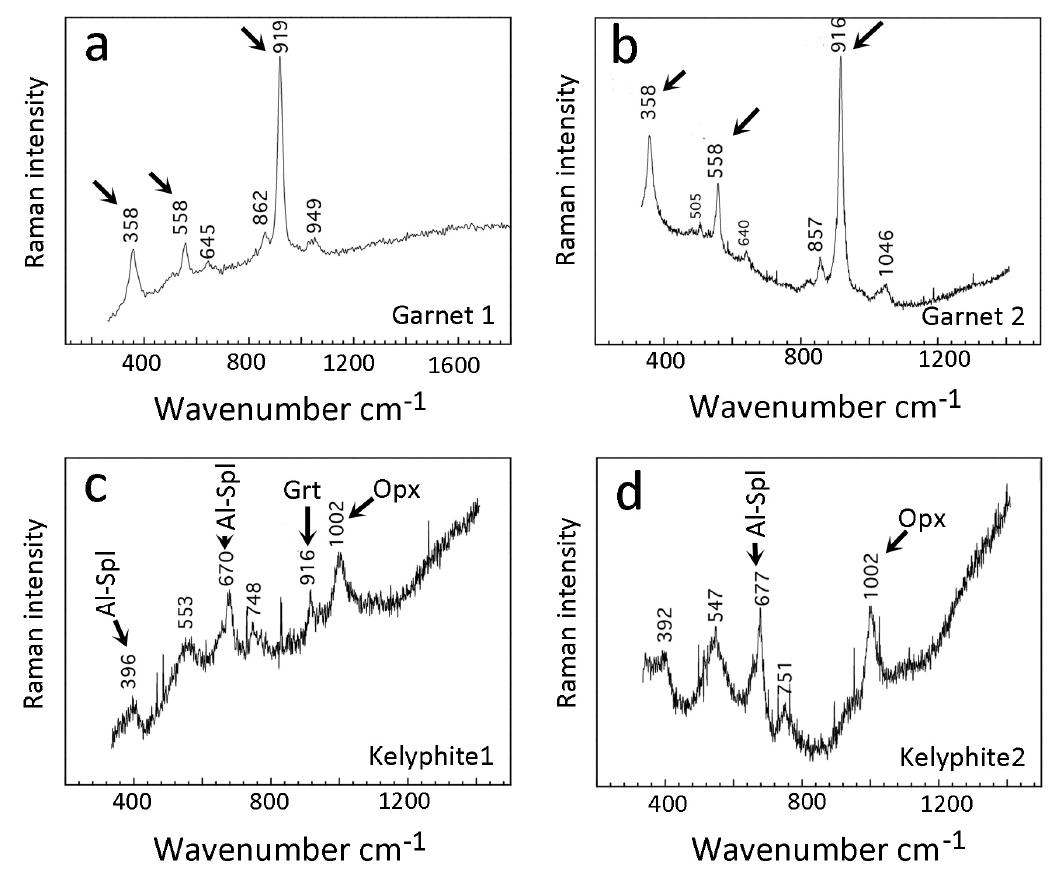
Figure 7. Micro-Raman spectra of garnet grains ( a , b ) and tiny portions of fine kelyphite ( c , d ). Full explanation is reported in the text.